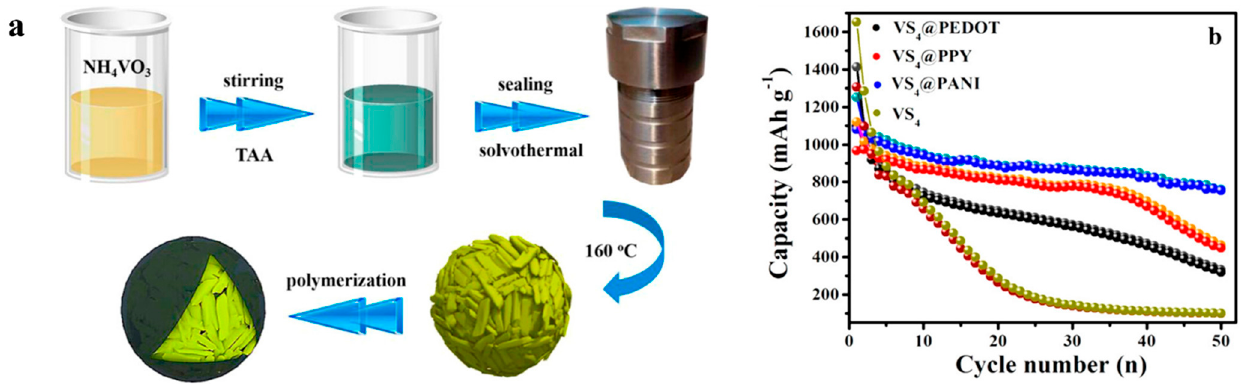
Figure 10. ( a , b ) Synthesis of the conductive-polymer-coated VS 4 sub-micro-spheres and the discharge profiles of VS 4 @PEDOT, VS 4 @PPY, and VS 4 @PANi. Reproduced from Ref. [198] with permission from the American Chemical Society.